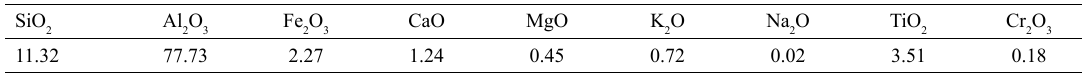
Table 1. Chemical composition of high alumina bricks